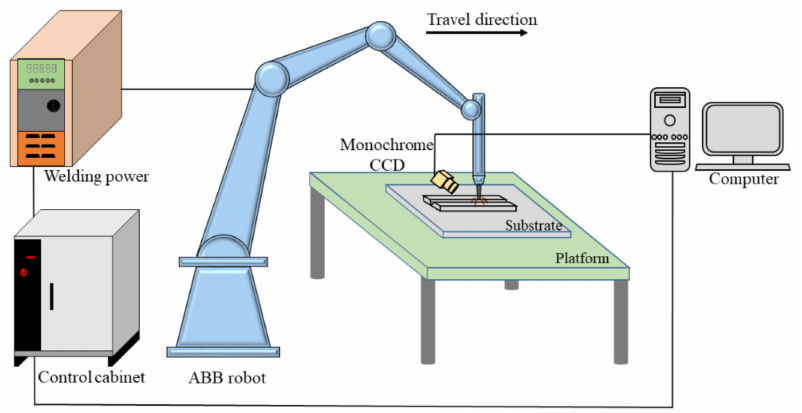
Figure 1. Schematic diagram of experimental equipment.